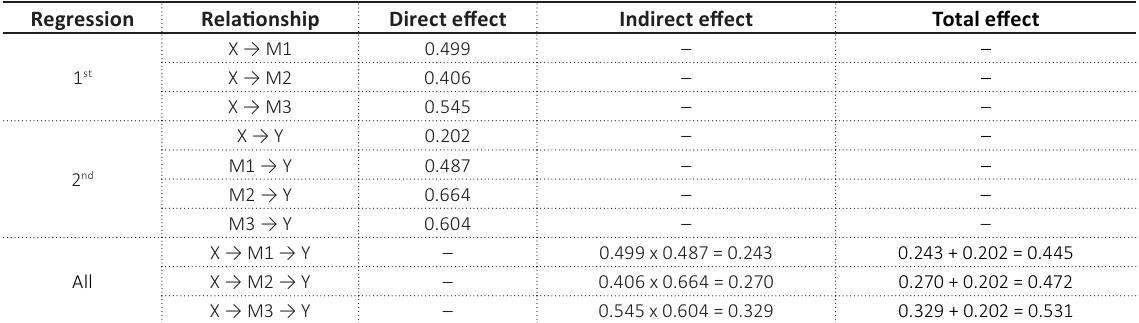
Table 11. Summary of direct and indirect effects